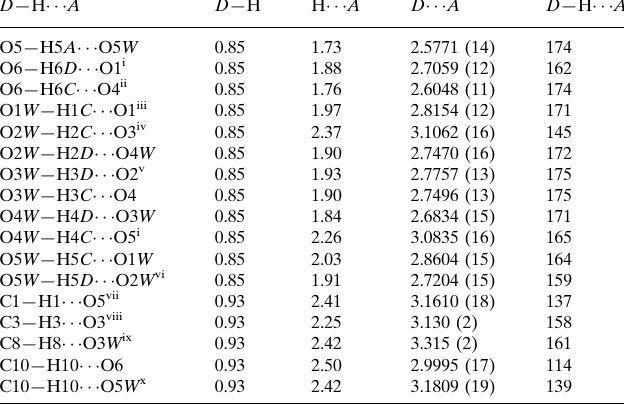
Hydrogen-bond geometry (A˚ , (cid:4) ). D —H (cid:1)(cid:1)(cid:1)